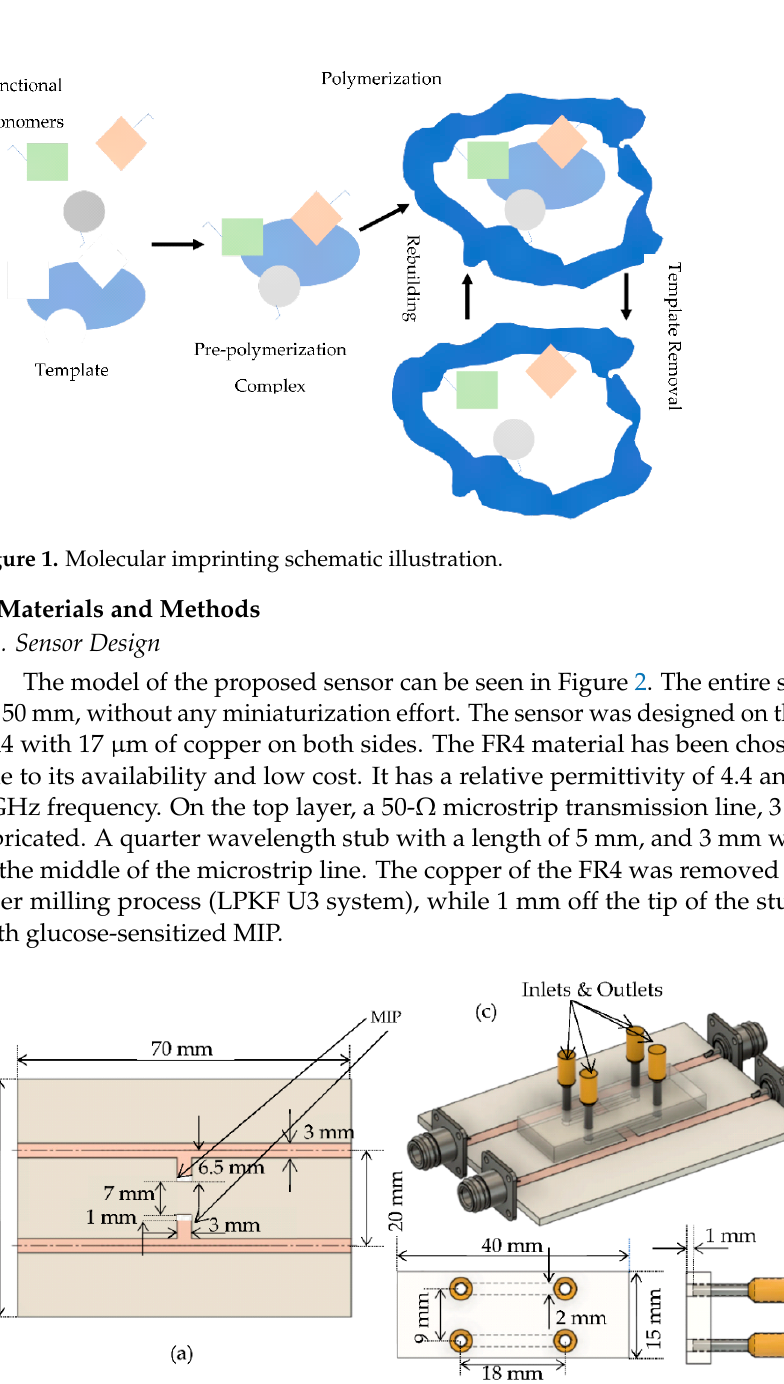
Figure 1. Molecular imprinting schematic illustration.